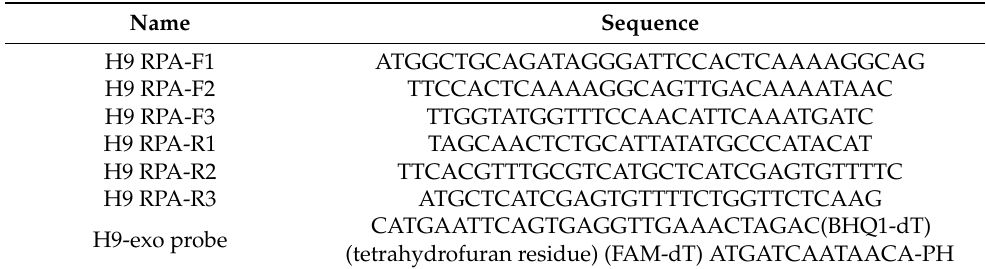
Table 1. Primers and exo-probe used for H9